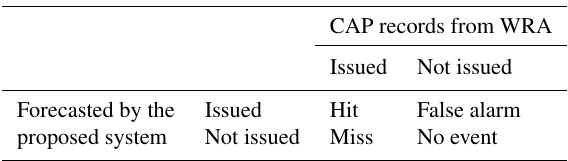
Table 2. Contingency table used for the system performance evalu-